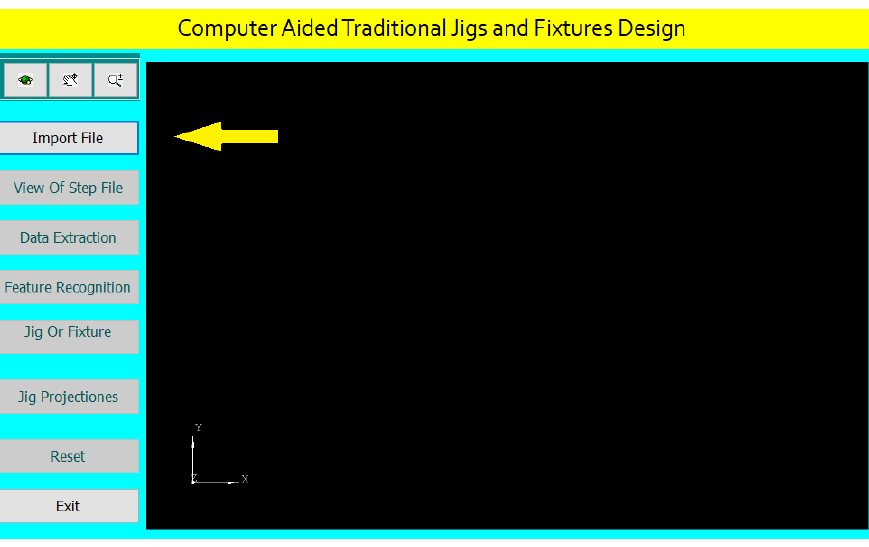
Figure 7. The first screen of the system interface.